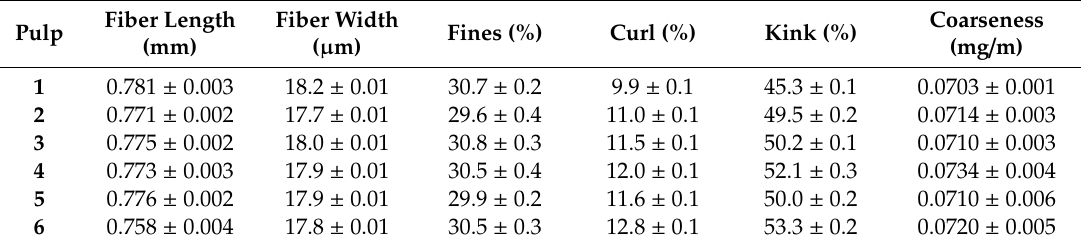
Table 2. Fiber morphology parameters of defiberized eucalypt kraft flu ff pulps.